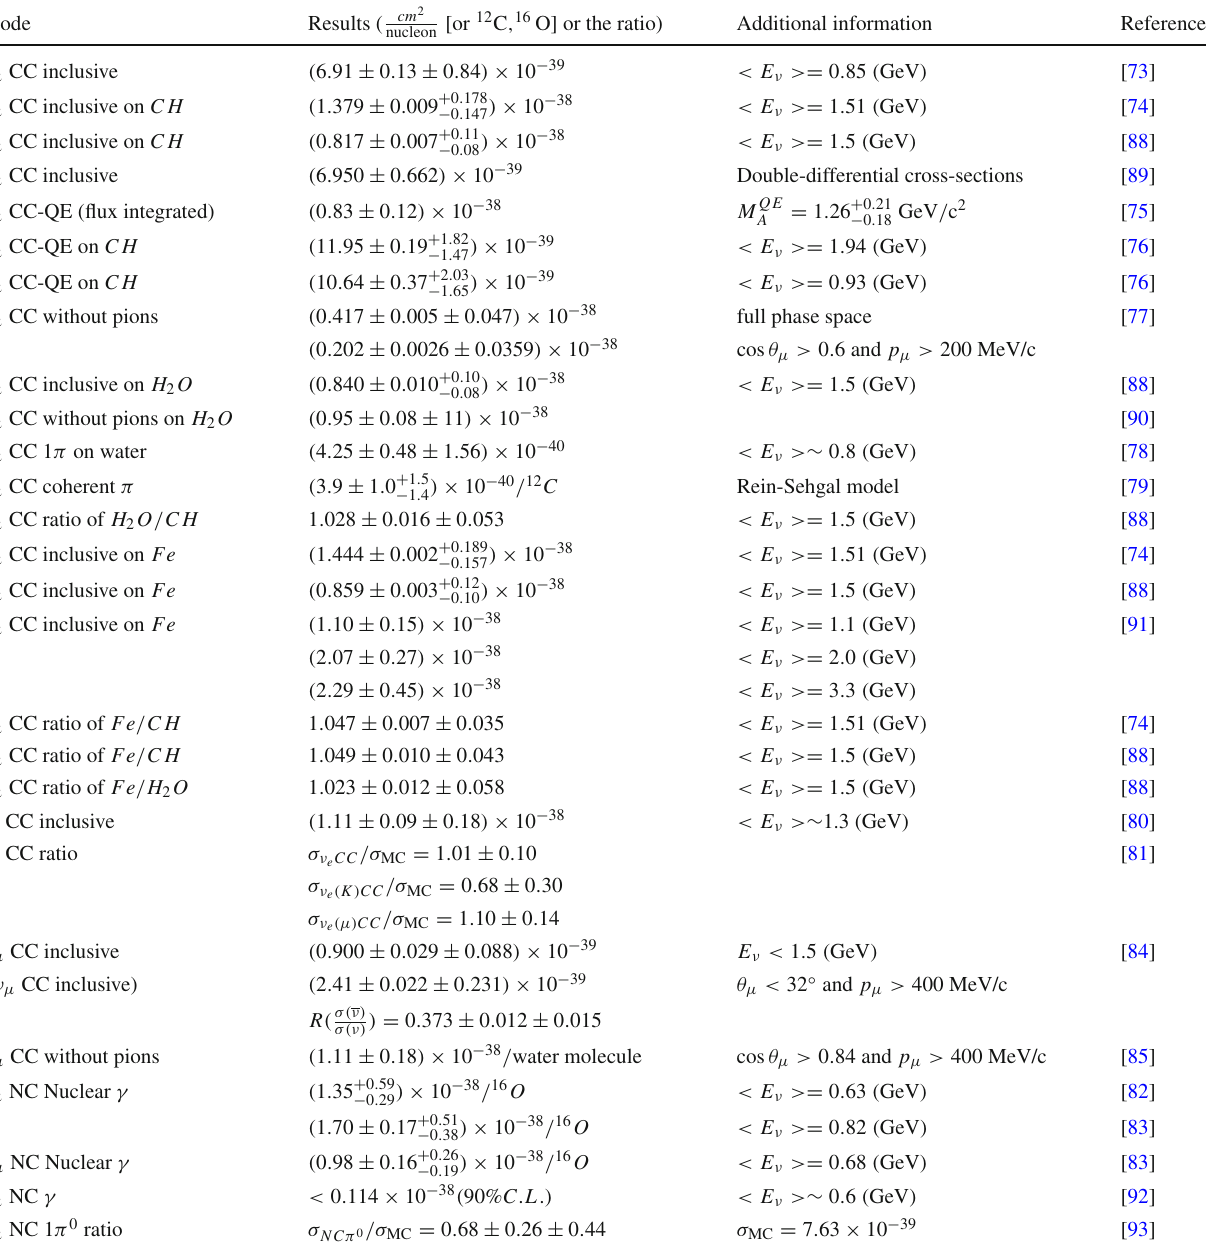
Table 20 Neutrino and antineutrino cross-section measurements in on Carbon unless otherwise stated. The first error is statistical and the T2K for Charged Current (CC) and Neutral Current (NC) processes. second is systematic. The ratio of the cross section to the MC model The cross-section measurements are given in units of cm 2 per nucleon prediction ( σ MC ) is also shown for some measurements [ or 12 C , 16 O ] or the Mode Results ( cm 2 nucleon